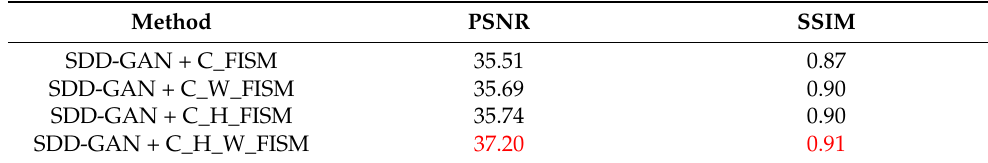
Table 7. Average PSNR and SSIM on the RSDATA dataset (using C_FISM, C_W_FISM, C_H_FISM, or C_H_W_FISM). The highest scores are highlighted in red.